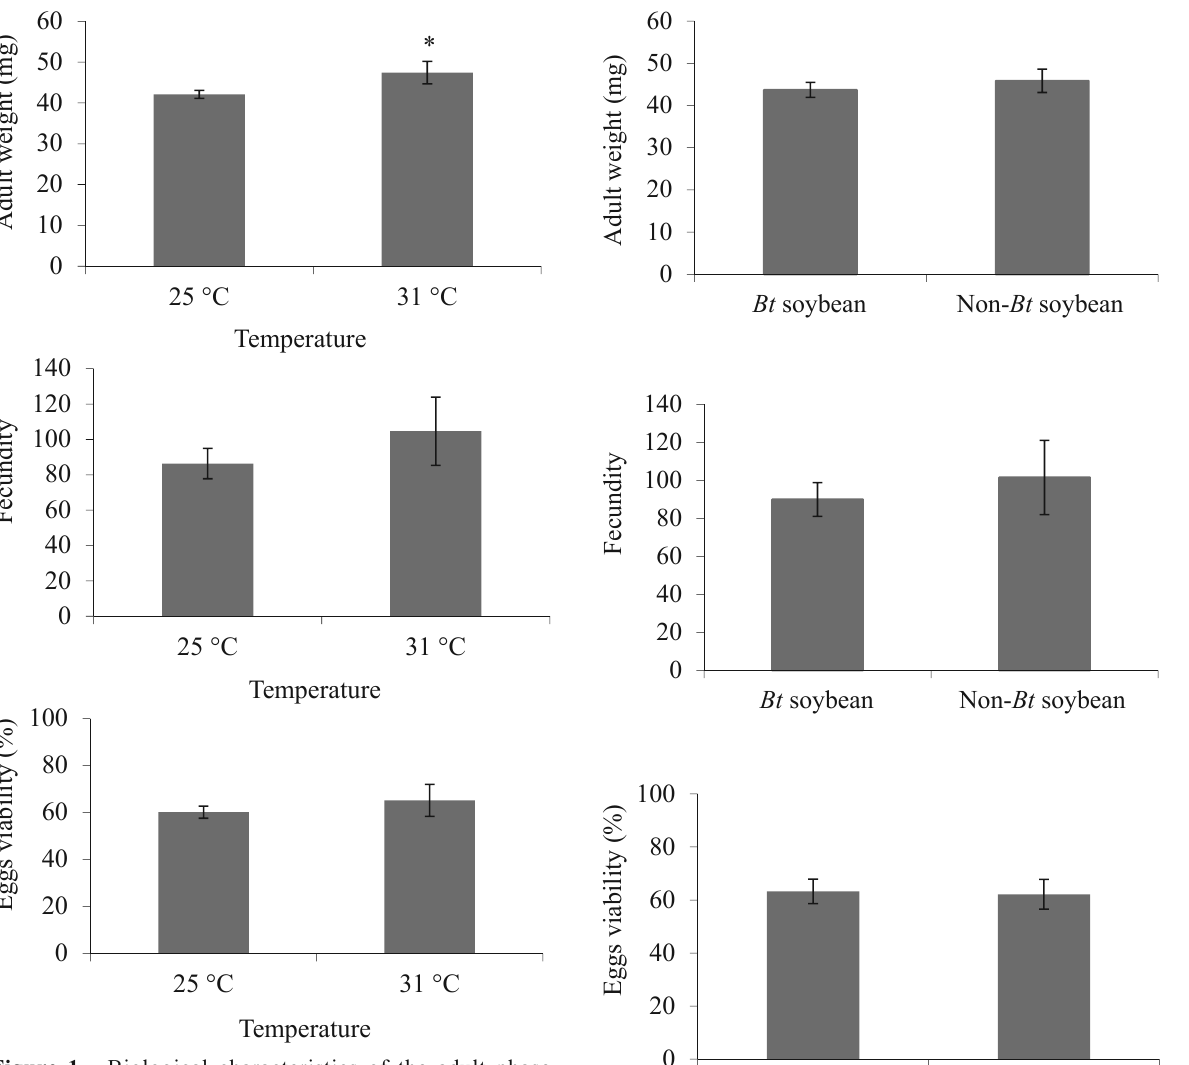
Figure 1 - Biological characteristics of the adult phase Dichelops melacanthus developed with soybean pods submit- ted at different constant temperatures. Means were compared by Tukey test (* = P ≤ 0.05). (PS. At the temperature of 19 °C hatched only 1 adult individual, not allowing to perform statistical B IOLOGY OF T. podisi D EVELOPED IN E GGS OF D.